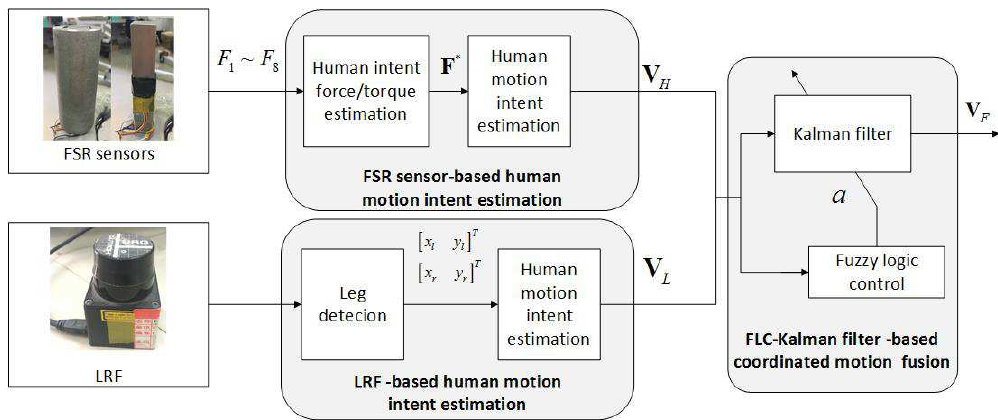
Figure 6. The fuzzy logic control (FLC)-Kalman filter-based coordinated motion fusion algorithm for the walking-aid robot.